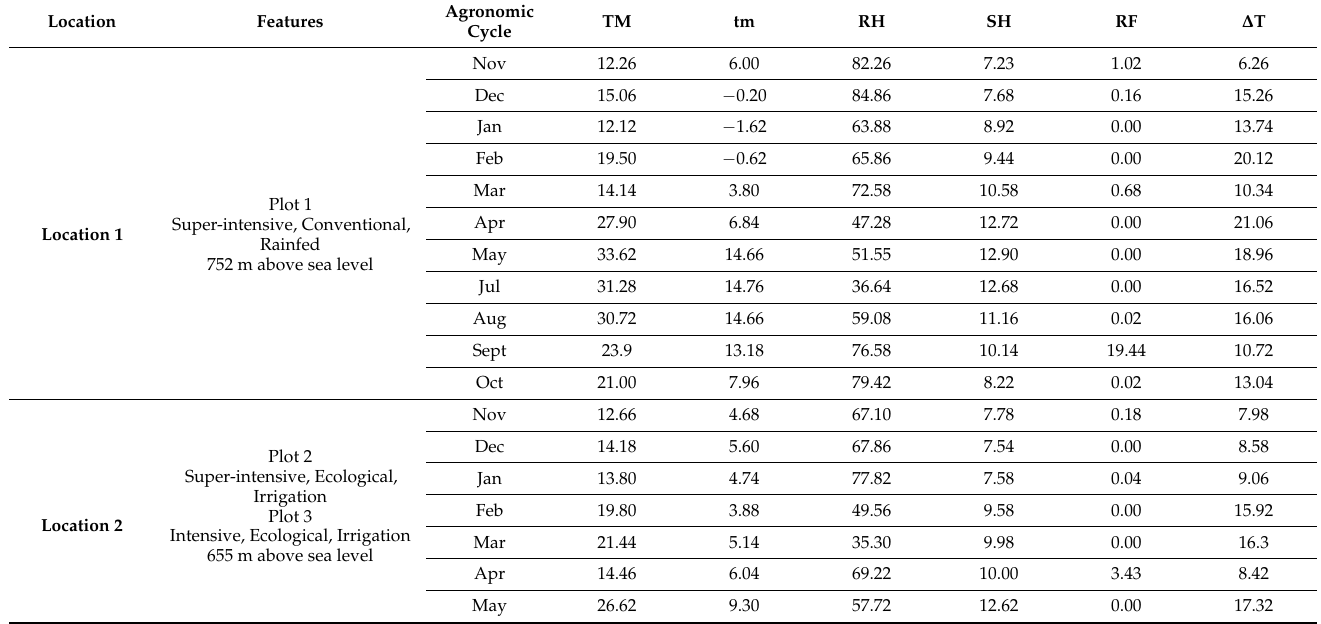
Table A1. Climatic conditions for each sampling carried out in the different